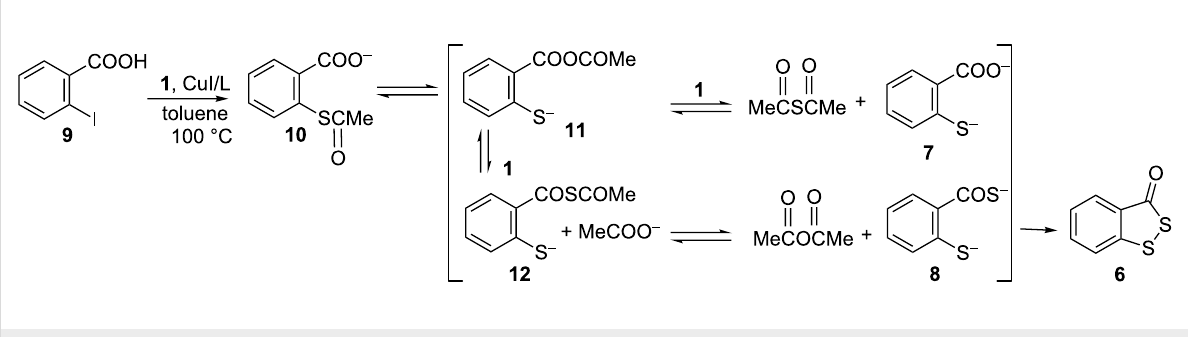
Scheme 5: Suggested one-pot synthesis of heterocycle 6 .